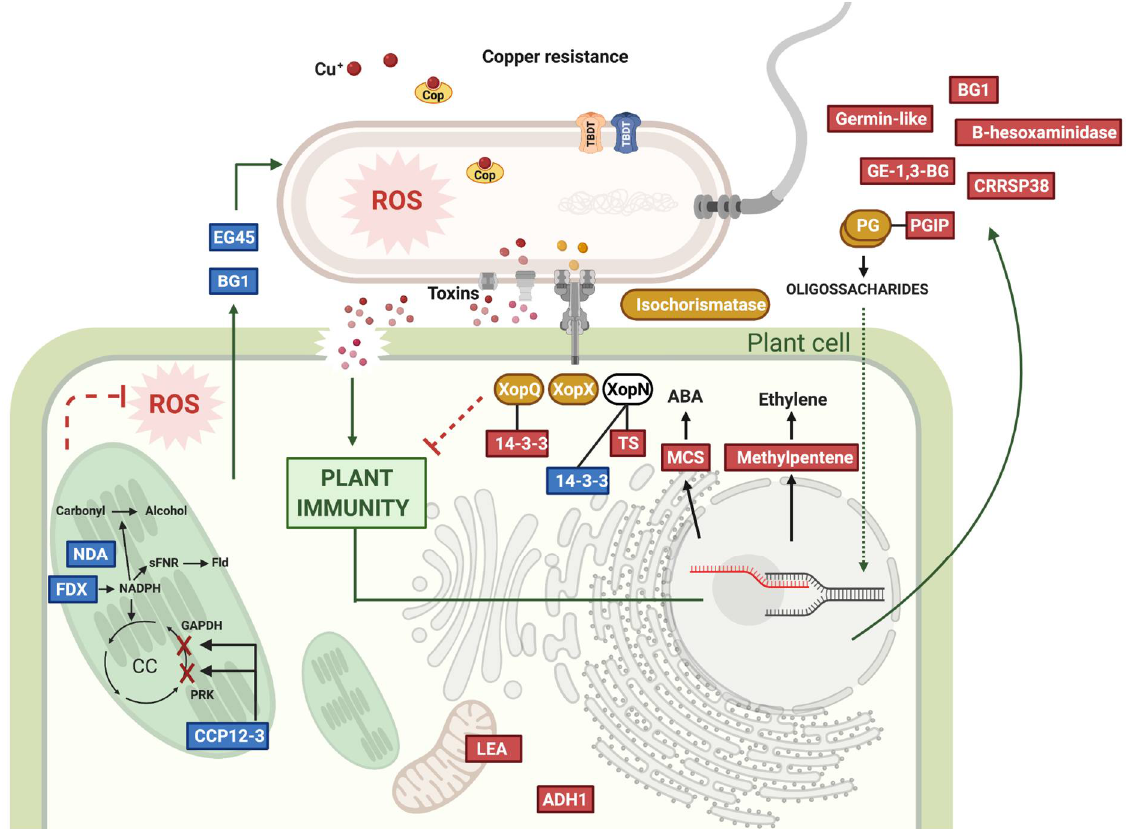
Figure 4. Model of Xanthomonas arboricola pv. juglandis (Xaj) and Juglans regia (Jr) interactome. Xaj (oval shape) and Jr (rectangular shape) proteins. Proteins with increased abundance are shown in red and yellow to represent proteins from Jr and Xaj respectively. Jr decreased proteins are represented in blue rectangles. EG45: EG45-like domain containing protein, BG1: probable glucan endo-1,3-beta-glucosidase, NDA: NADPH-dependent alkenal/one oxidoreductase (AtAOR), FDX: ferredoxin-2, CCP12-3: Calvin cycle protein CP12-3, TBDT: TonB-dependent transporter, PG: polygalacturonase, PGIP: polygalacturonase-inhibitor, GE-1,3-BG: probable glucan endo-1,3-beta-glucosidase At4g16260, CRRSP38: cysteine-rich repeat secretory protein 38, 14-3-3: 14-3-3-like protein, TS: thiamine synthetase, MCS: molybdenum cofactor sulfurase, LEA: late embryogenesis abundant proteins. ADH1: alcohol dehydrogenase class-P. This figure was created in BioRender.com (accessed on 1 September